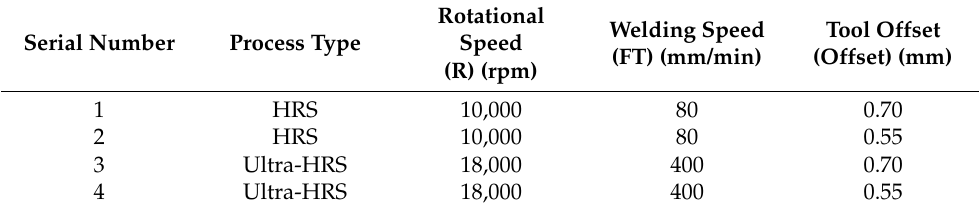
Table 2. The process parameters used regarding the HFSW of Al 6061 to 316L steel.